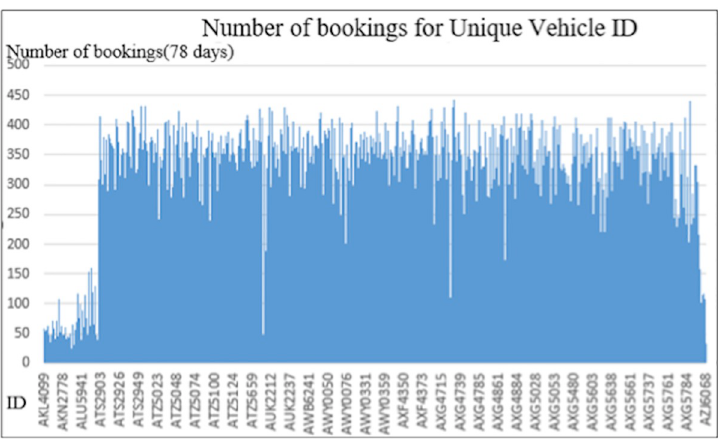
https://doi.org/10.1371/journal.pone.0223973.g001